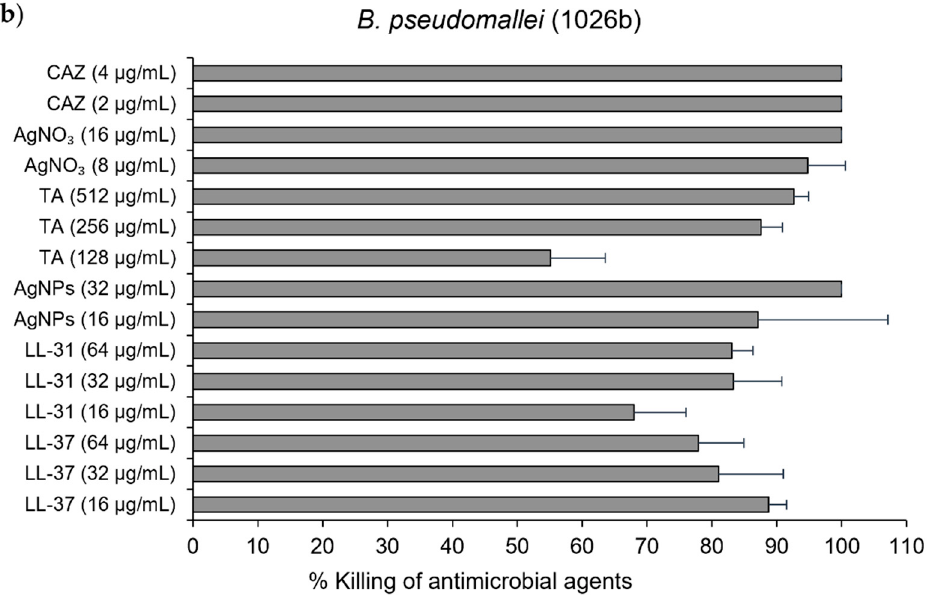
Figure 3. % killing of antibacterial agents, LL-37, LL-31, and AgNPs. CAZ, AgNO 3 and tannic acid (TA) were used as the positive control): ( a ) against Escherichia coli (O157: H7); ( b ) and B. pseudomallei (1026b). Data are represented as mean and standard deviation of two independent experiments performed in triplicate ( n = 6). % killing was calculated from [1 − (CFU sample /CFU control )] × 100%. Table 2. MIC and MBC of AgNPs and CAZ against B. pseudomallei strains 1026b, H777 and 316c